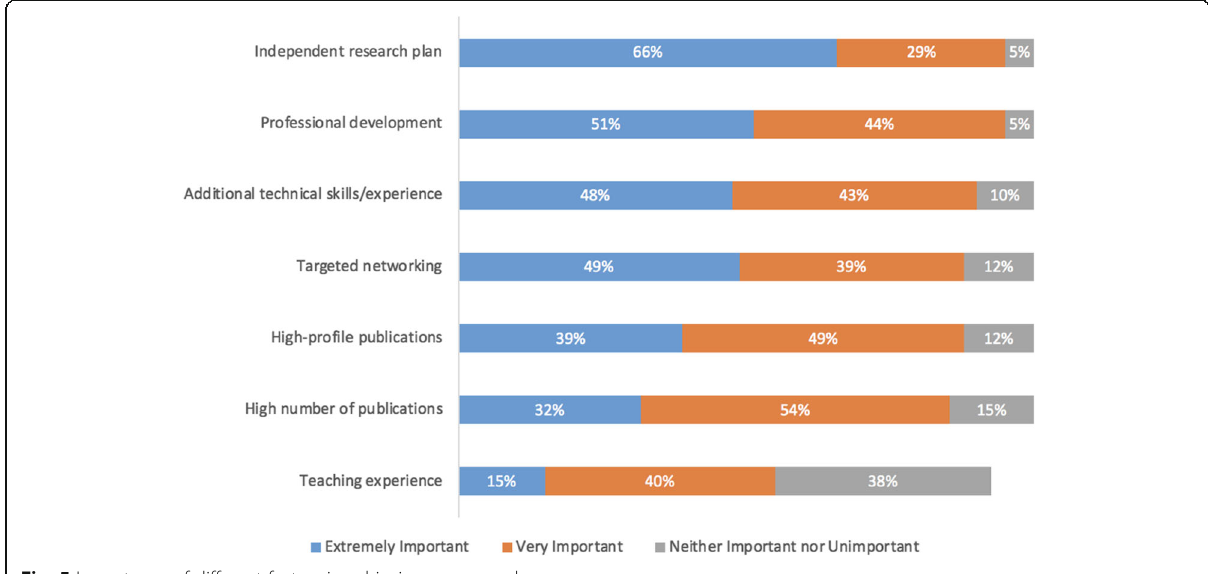
Fig. 5 Importance of different factors in achieving career goal